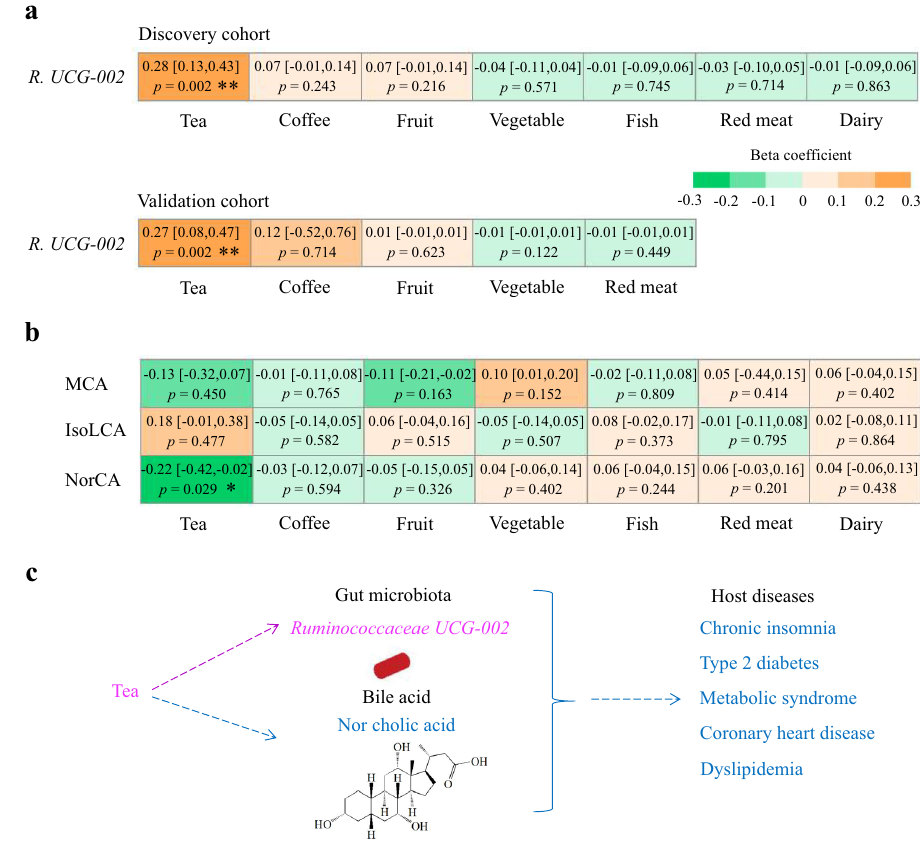
Fig. 3 Association of the chronic insomnia-related gut microbiota-bile acid axis with cardiometabolic diseases. Multivariable logistic regression was used to estimate the association of the chronic insomnia inverse-related microbial biomarkers Ruminococcaceae UCG-002 ( a ) and Ruminococcaceae UCG- 003 ( b ) with different CMD in the discovery and validation cohorts, respectively. The effect estimates from the discovery and validation cohorts were pooled using random effects meta-analysis. c Multivariable logistic regression was used to estimate the association of the chronic insomnia-related bile acid biomarkers with CMD in the discovery cohort. d The prospective associations of the above identi fi ed gut microbiota biomarkers (measurement of gut microbiota data at the second follow-up) with the incidence of CMD (dyslipidemia) at the third follow-up using multivariable logistic regression, adjusted for potential confounders. Error bars in a – d are odds ratios with 95% con fi dence intervals. e Associations of the identi fi ed gut microbiota and bile acid biomarkers with CMD-related risk factors (BMI, DBP, SBP, waist circumference, fasting serum TG, TC, HDL, LDL, glucose, insulin, and HbA1c) using multivariable linear regression model in the GNHS, adjusted for potential confounders. f Parallel coordinate chart showing the association among gut microbes, bile acid biomarkers and CMD outcomes. The left panel shows the microbial biomarkers, the middle panel shows the bile acid biomarkers, and the right panel shows the CMD outcomes. The red lines across panels indicate the positive association. The green lines across panels indicate the inverse association. g The chronic insomnia inverse-related microbial biomarker Ruminococcaceae UCG-002 affects risk of MetS and T2D though speci fi c bile acid biomarkers, respectively. h The chronic insomnia inverse-related microbial biomarker Ruminococcaceae UCG-003 affects the risk of MetS and T2D through speci fi c bile acid biomarkers, respectively. The gray lines indicate the associations, with corresponding normalized beta values and p values. The red arrowed lines indicate the microbial effects on CMD mediated by speci fi c bile acid biomarkers, with the corresponding mediation p values. p value < 0.05 is considered signi fi cantly different. Throughout the above analyses, FDR from multiple testing was controlled by the Benjamini-Hochberg method. All statistical tests were two-sided. Source data are provided as a Source Data fi le. CMD cardiometabolic disease; T2D type 2 diabetes; MetS metabolic syndrome; SBP systolic blood pressure; DBP diastolic blood pressure; TG triglycerides; TC total cholesterol; HDL high-density lipoprotein cholesterol; LDL low-density lipoprotein cholesterol; HbAlc glycated hemoglobin.